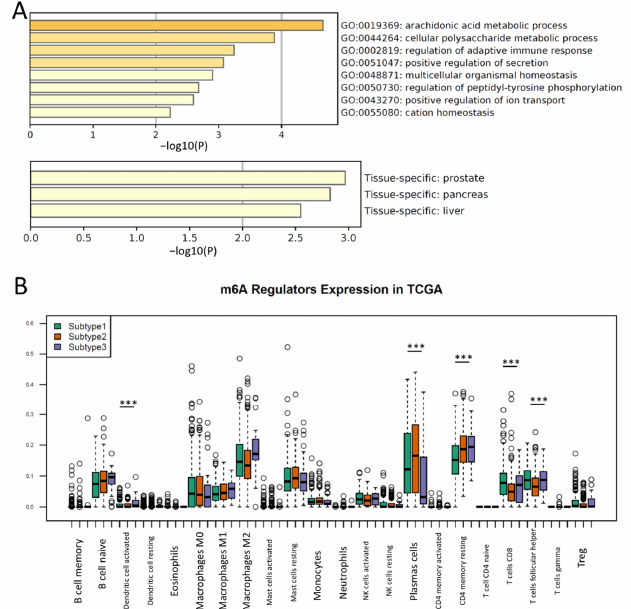
Figure 2. Different responses of immune cells are enriched in the three subtypes of PCa. ( A ) Pathways of DEG between m 6 A subtypes are enriched in the metabolic process and immune response (upper). The subtype-specific DEGs are enriched in PCa (lower). ( B ) Boxplot showing the different immune cell infiltrations between m 6 A subtypes. ANOVA test; ***, p < 0.0001. 3.3. Clustering of m 6 A Regulators Was Associated with Progression in PCa To test whether the clustering of m 6 A regulators was associated with prostate patient outcomes, we compared the survivals in each subtype. Interestingly, there were no signif- icant differences in overall survival across all m 6 A subtypes ( p = 0.7, Log-rank test), but patients in Subtype 3 had a worse recurrent-free survival ( p = 0.02, Log-rank test) (Figure 3A), suggesting that PCa recurrence was likely modulated by m 6 A regulators. Notably, the prognostic capacity of m 6 A regulator clustering was more significant in T3 PCa pa- tients than in T1 and T2 PCa (Supplementary Figure S5A,B). Considering that a few m 6 A regulators were differentially expressed between 55 normal prostate tissues and 454 pros- tate cancers (Supplementary Figure S3B) and PCa metastasis was a more critical event than recurrence, we then compared the m 6 A expression in the GSE147493 dataset, which included PCas with or without metastasis. Seven of 21 m 6 A regulators (HNRNPA2B1, FMR1, METTL14, KIAA1429, YTHDF1, ALKBH5, HNRNPC) displayed different expres- sion patterns between 62 metastatic and 37 non-metastatic PCas (Figure 3B), suggesting that these seven m 6 A regulators were associated with PCa metastasis. More importantly, we also observed that the subtypes clustered by m 6 A regulators were associated with